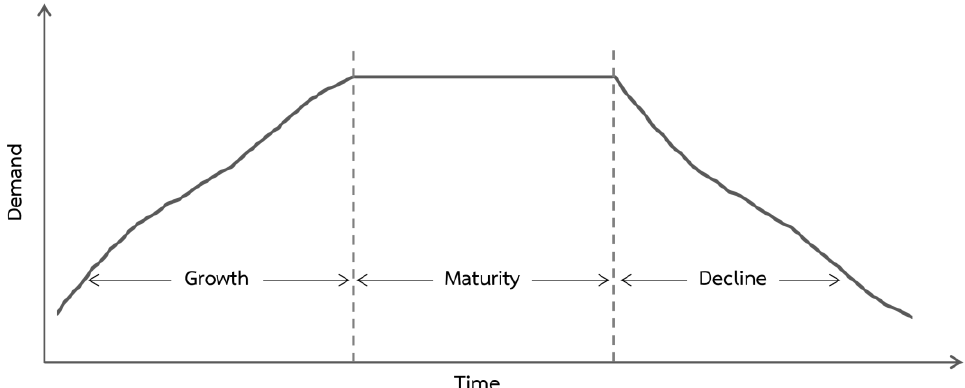
Figure 3. Stages of product life cycle.